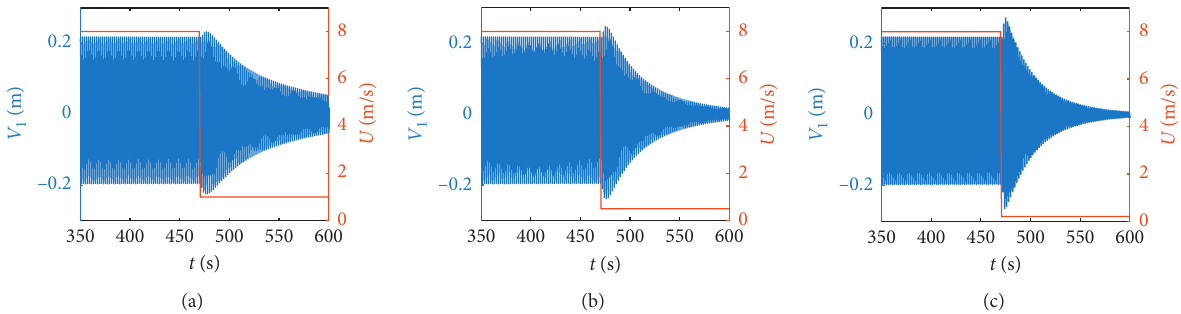
Figure 6: Time history of the first in-plane modal galloping with wind speed reduction at U U 2 � 0.5m/s. (c) U 2 � 0